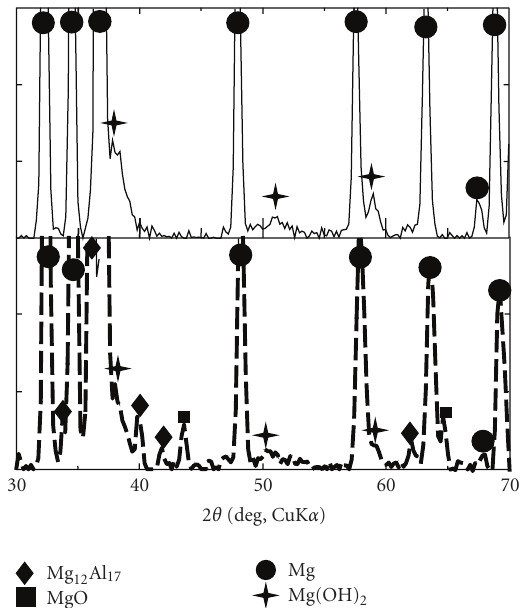
Figure 9: The XRD pattern of anodic film on AZ31 and AZ91 magnesium alloys.